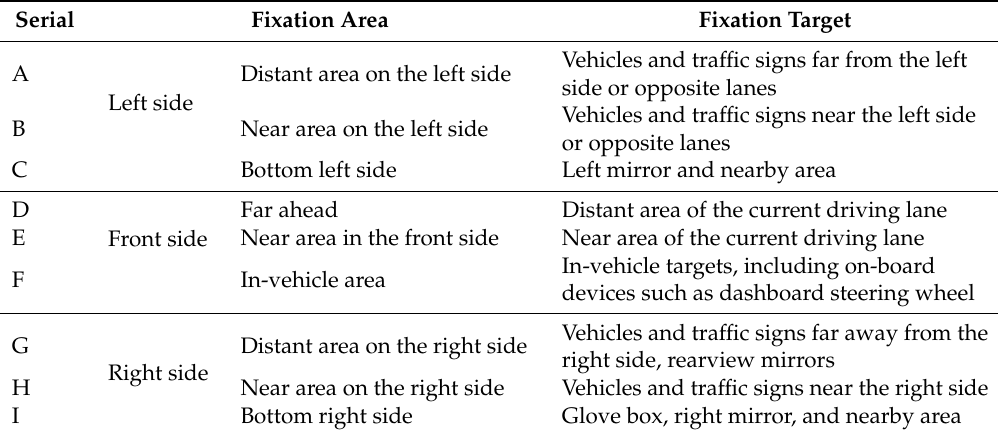
Table 3. Description of AOI area and fixation target